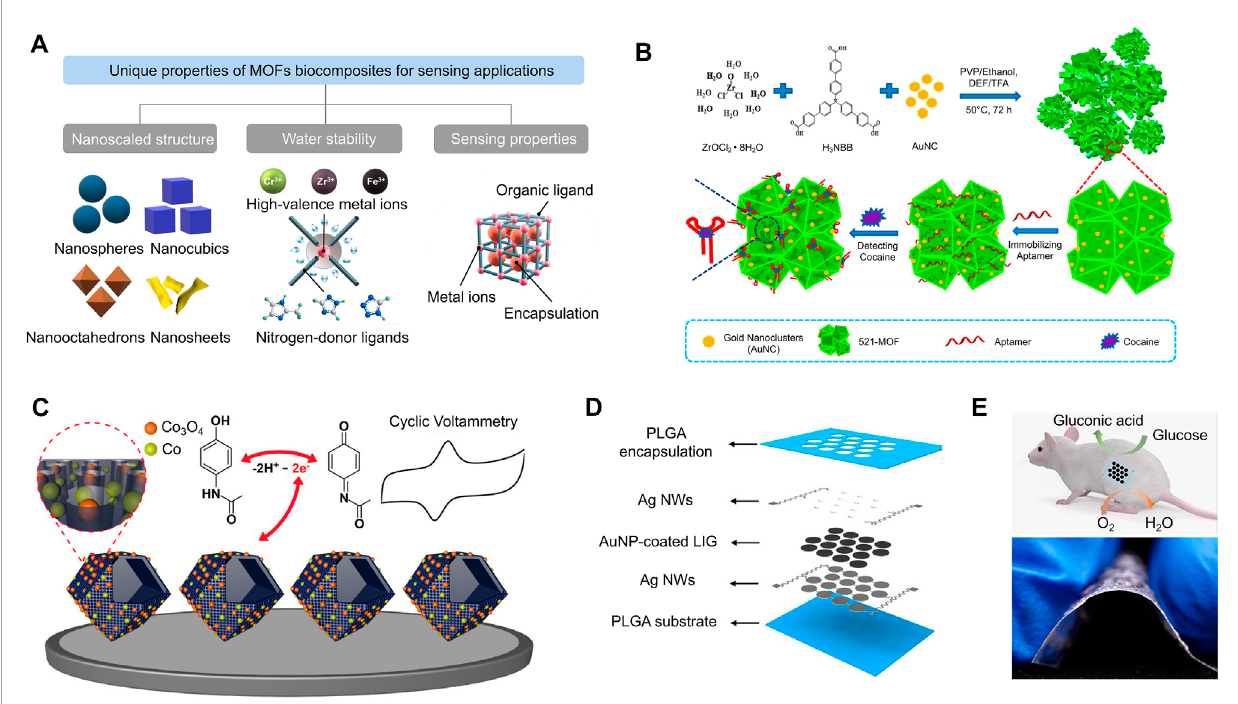
FIGURE 3 (A) MOFs have a variety of unique properties, such as nanoscaled structures and water stability, that make them useful for sensing applications. (B) A two-dimensional zirconium-based MOF (denoted 521-MOF) was conjugated to gold nanoclusters (AuNCs) in a one-pot reaction to serve as an aptamer-based biosensor for the detection of cocaine. (C) Co / Co 3 O 4 nanoparticles are coupled with hollow nanoporous carbon polyhedrons for the enhanced electrochemical sensing of acetaminophen. (D) A graphic representation of a transient enzymatic biofuel cell array composed of LIG/Au nanoparticles, which is used as a nanogenerator for low-power implantable devices. (E) Implantation of the transient enzymatic biofuel cell array into a mouse model (top) and showing its flexibility (bottom). [adapted and modified from (Su et al., 2017; Qiu et al., 2019; Wang et al., 2019; Huang et al.,